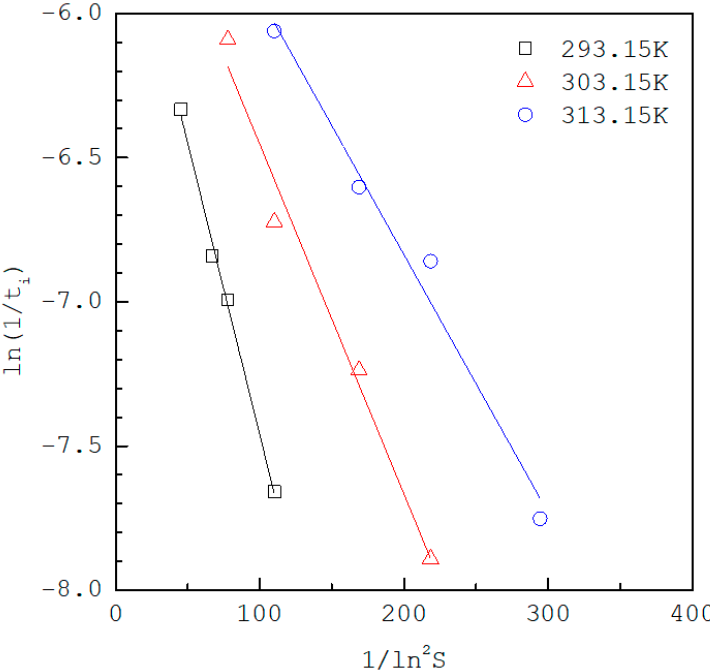
Figure 5. The induction time data of L-glycine at 293.15–313.15 K fitted to Equation (3) based on f N